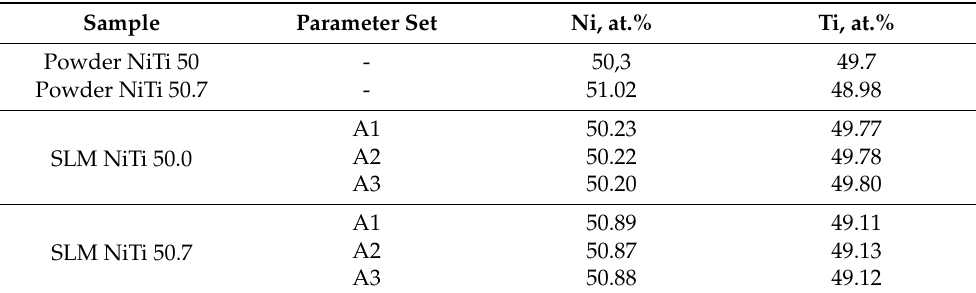
Table 5. The results of studying the chemical composition of powder and samples after the SLM process.